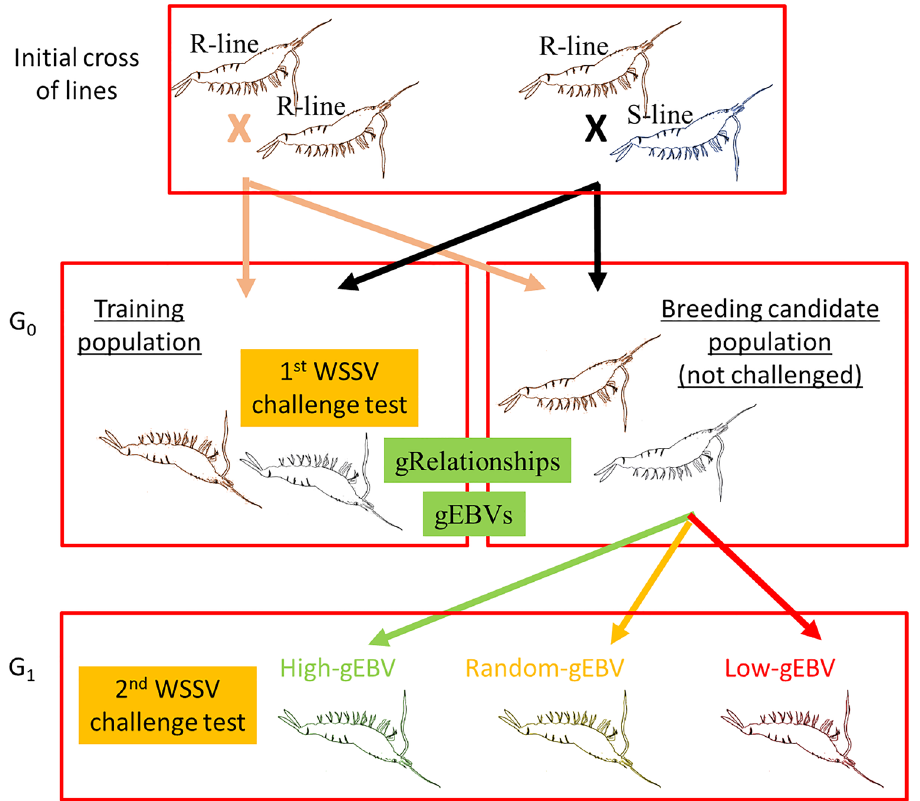
Figure 5. Origin of shrimp for the experiment. The animals were split into training and candidate breeding populations for estimation of white spot syndrome virus (WSSV) resistance genomic estimated breeding values (gEBV) at generation G 0 . G 0 breeding candidates were selected and mated to produce high, random and low gEBV G 1 groups whose performance (survival after an experimental challenge test) was compared for the final evaluation of the power of genomic